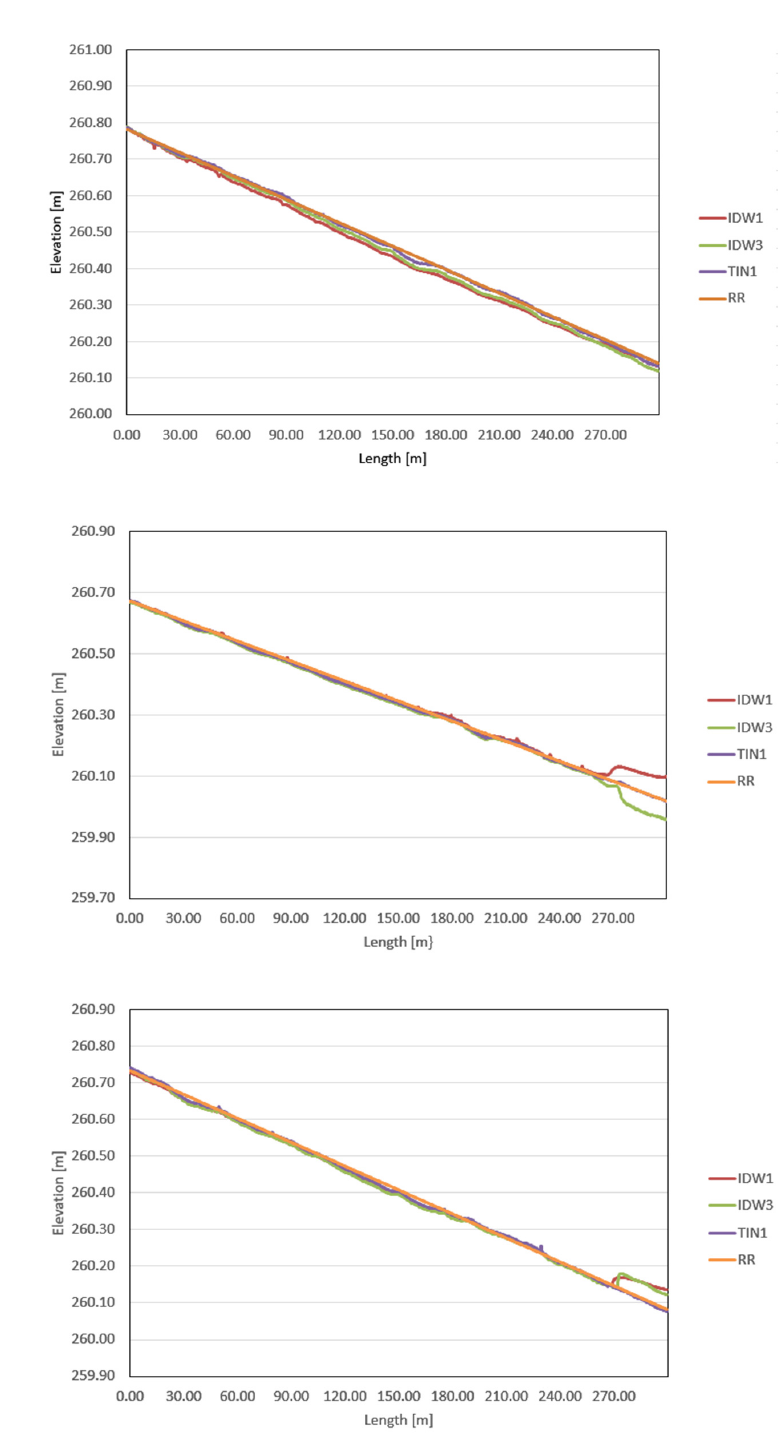
Figure 8. Runway modelling in longitudinal cross-section P1, P2, and P3 by selected models.